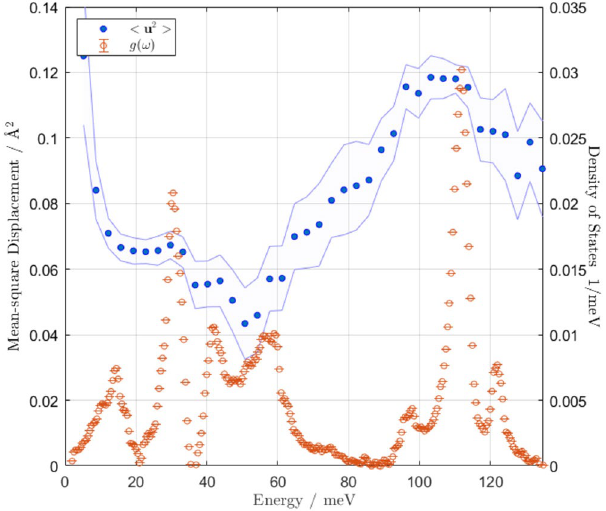
Figure 7. Calculated mean-square displacement (Debye–Waller factor) as a function of energy for 175 meV incident energy neutrons. The blue points (left axis) are calculated by fitting binned regions of S Q ( , ) ω (Fig. 2) to Equation 5. The error channel represents a 95% confidence interval. The tan points (right axis) are the reproduced experimental gdos (Fig. 3) for comparison. The mean-square displacement parameter is responsible for attenuation of scattered intensity as a function of Q . Since hydrogen is much lighter than the other sample constituent elements, the same kinetic energy is associated with a larger mean displacement from equilibrium. By identifying regions of larger mean-square displacement in the phonon spectrum, we identify regions of stronger H-coupling to the lattice. In particular, the uranyl stretching region (90–130 meV) shows the strongest Q attenuation in ω S Q ( , ) and the strongest mismatch between the calculated and measured gdos (Fig. 3), both indicative of significant